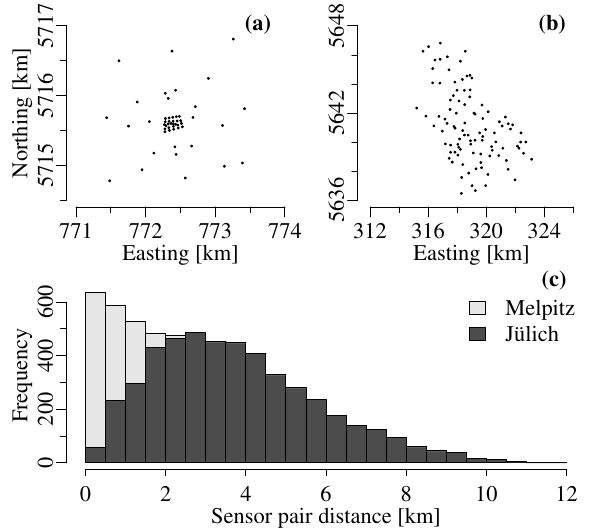
Figure 1. Panels (a, b) show maps of the coordinates (UTM projec- tion, grid zone 32U) of all pyranometers deployed during the two field campaigns in (a) Melpitz and (b) Jülich. Panel (c) displays a histogram of the combined station pair distances from both data